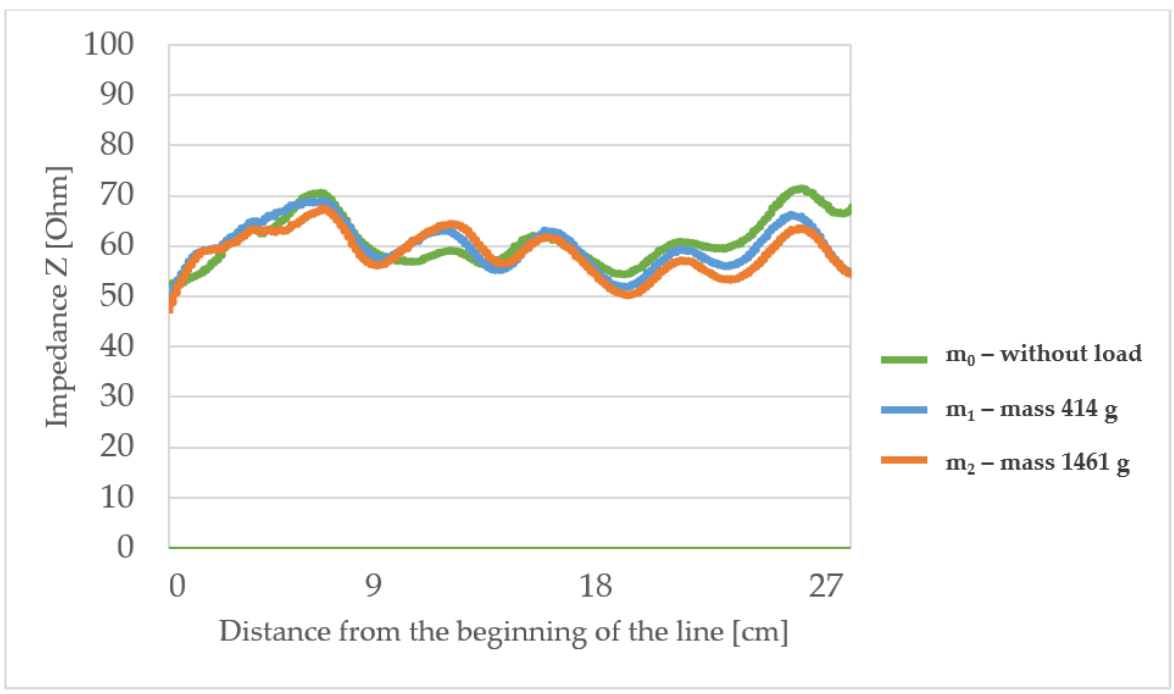
Figure 8. The profiles of the characteristic impedance of the textile signal line L3.